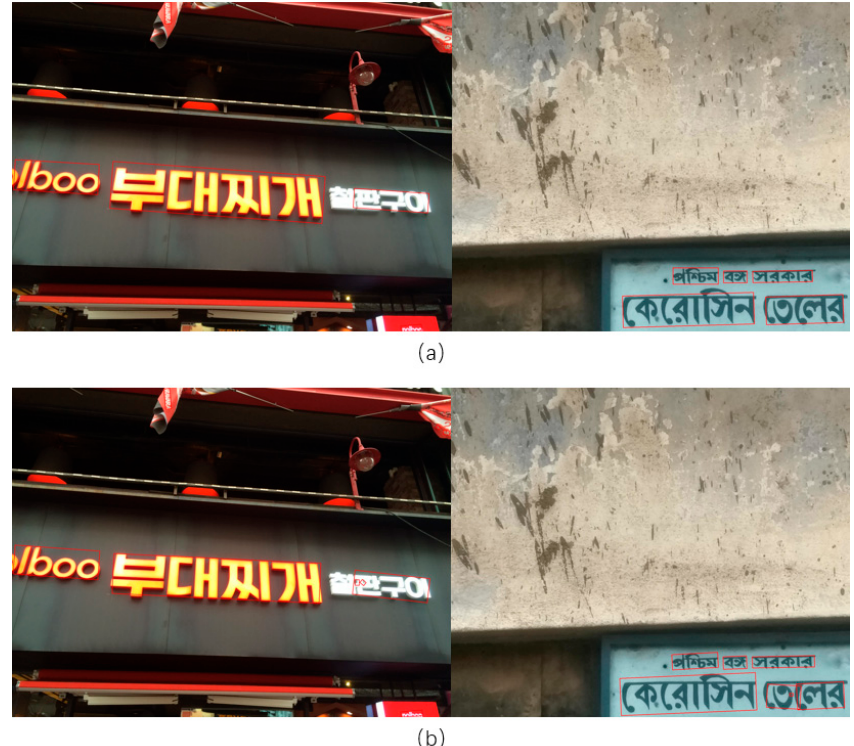
Figure 11. Comparison of visualization results between the method proposed in this paper and the original DBNet model on the ICDAR2017-MLT dataset: ( a ) is the result of the proposed method in this paper, and ( b ) is the result of the original DBNet model.